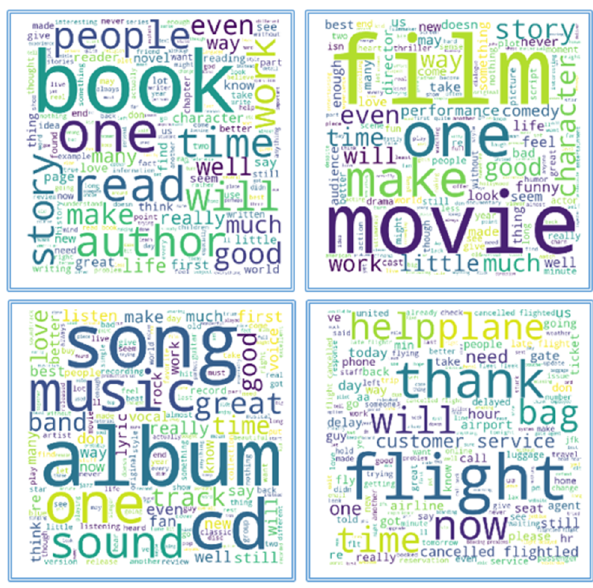
Figure 8. Word cloud view of the topics of the datasets.